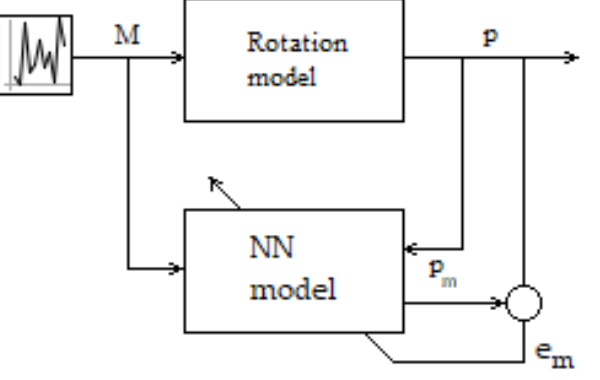
Figure 13. Block diagram of the neural model training.